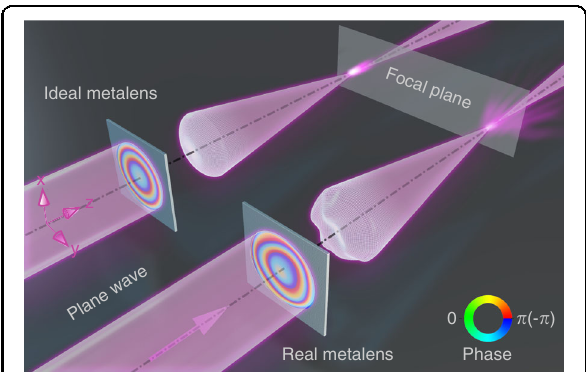
Fig. 1 Schematic diagram of the phase distribution determining the performance of a metalens. The concept art shows the comparison of metalenses' working performance between the ideal phase and the real phase in a fi nite